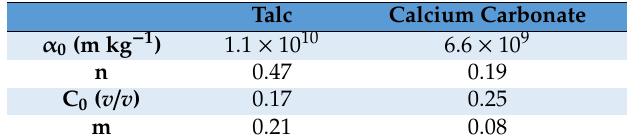
Table 2. Relevant filtration properties for the two solids